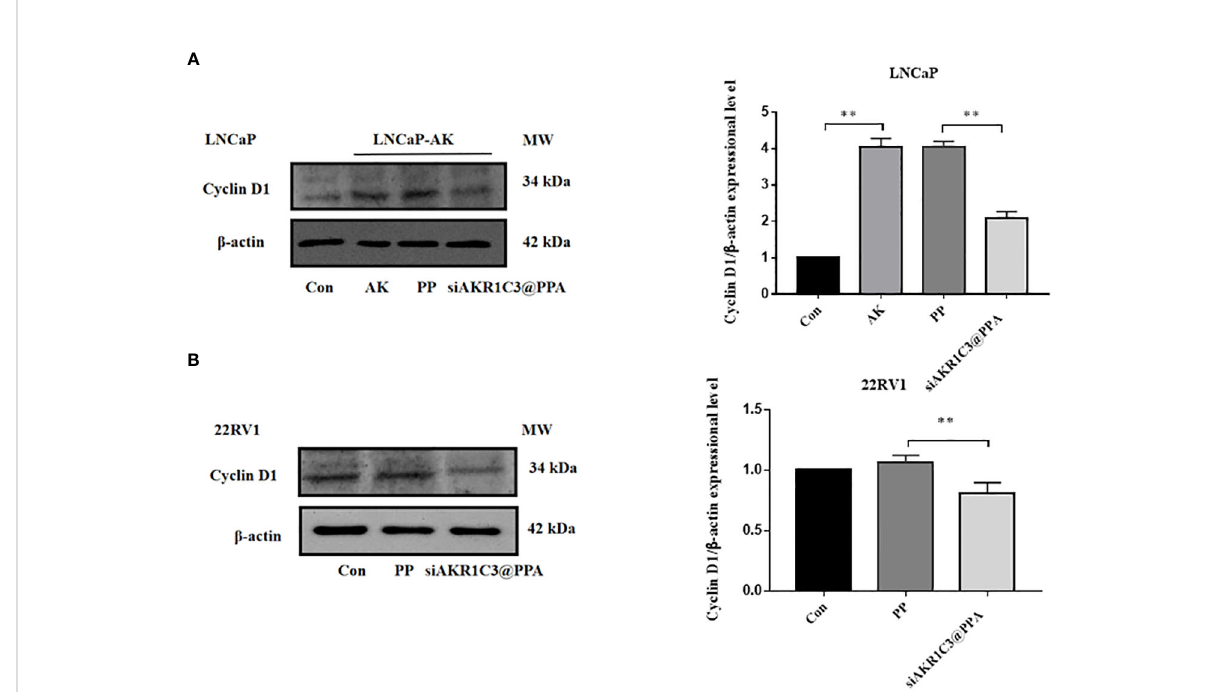
FIGURE 6 siAKR1C3@PPA affects the expression of cyclinD1 protein in LNCaP. (A) and 22RV1 (B) cells. Data are presented as the mean ± SD, n=3; **P <